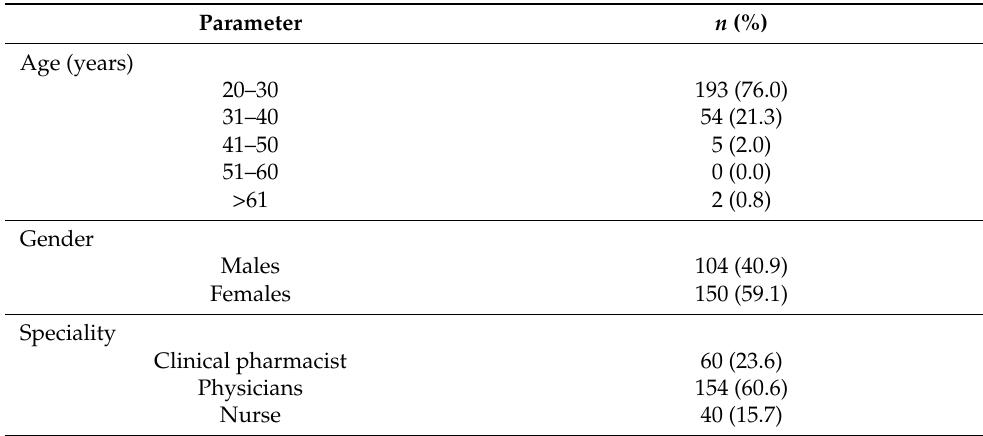
Table 1. Socio-demographic characteristics of the study sample ( n =